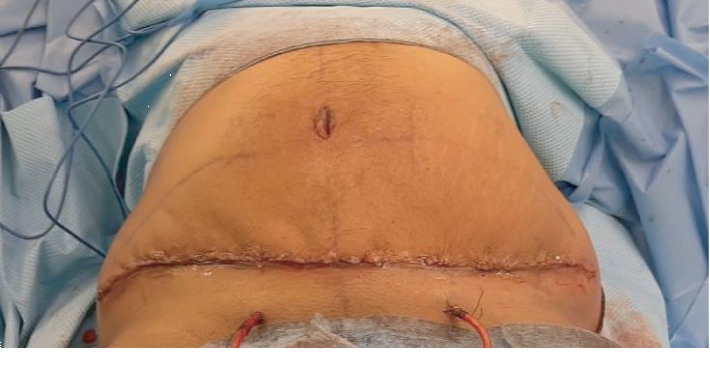
After skin closure.